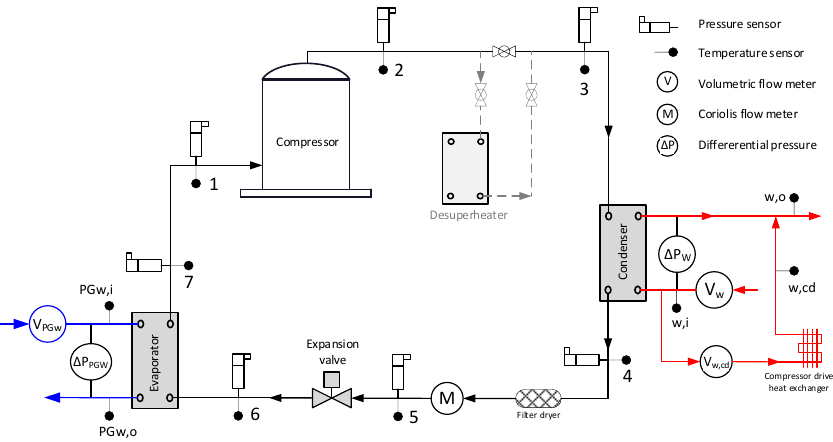
Figure 2. Schematic representation of the heat pump.